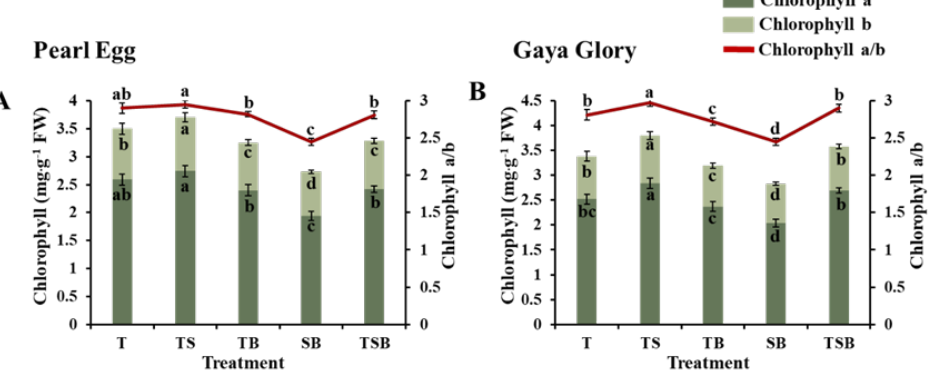
Figure 7. Changes in the chlorophyll content of chrysanthemum “Pearl Egg” ( A ) and “Gaya Glory” ( B ) plants in response to the different lighting direction combinations after 45 days of cultivation. T, TS, TB, SB, and TSB, refer top (1/1), top (1/2) + side (1/2), top (1/2) + bottom (1/2), side (1/2) + bottom (1/2), and top (1/3) + side (1/3) + bottom (1/3) lighting, respectively. Vertical bars indicate the means ± standard error ( n = 6). Different lowercase letters indicate the significant separation within treatments by Duncan’s multiple range test at p ≤ 0.05.